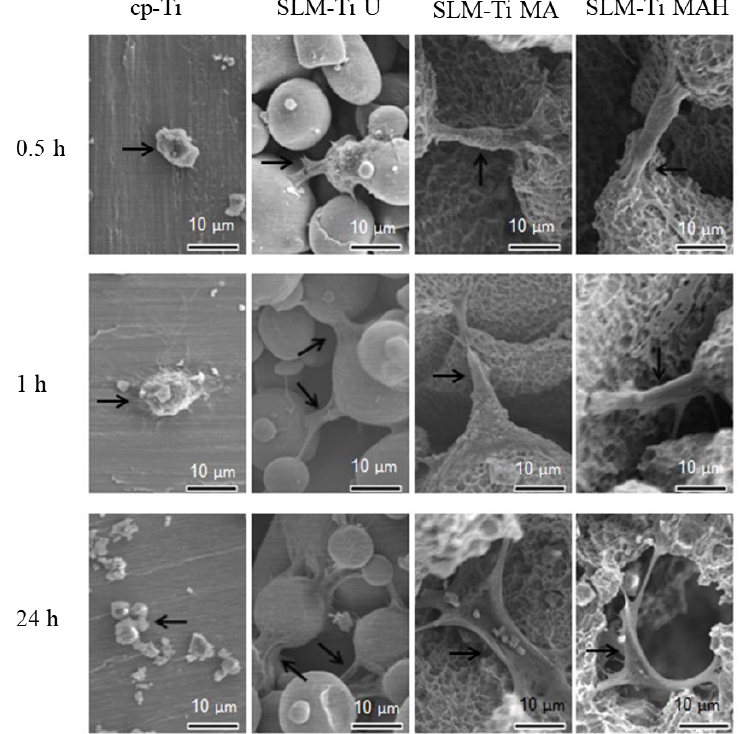
Figure 6. Morphology of MC3T3-E1 cells on cp-Ti and SLM-Ti surfaces after various incubation periods from 0.5 to 24 h. The black arrows indicate the cells.